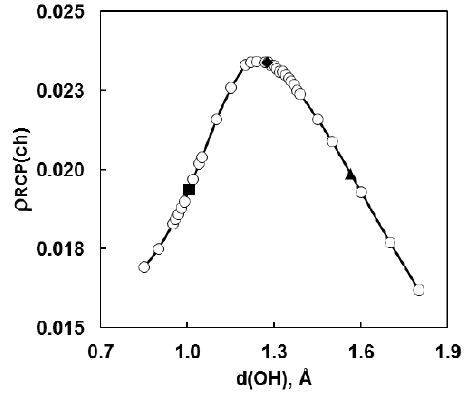
Figure 3. The dependence of the electron densities in the critical point of the quasi-aromatic ring (HO–C=C–C=N) on the length of hydroxyl bond of the ortho -hydroxyaryl Schiff base 1 (Figure 1, R 1 = R 2 = CH 3 ). Dark points correspond to: ■ —molecular form, ♦ —transition state and ▲ —PT form. Reprinted with permission from [12]. Copyright 2008 American Chemical Society.